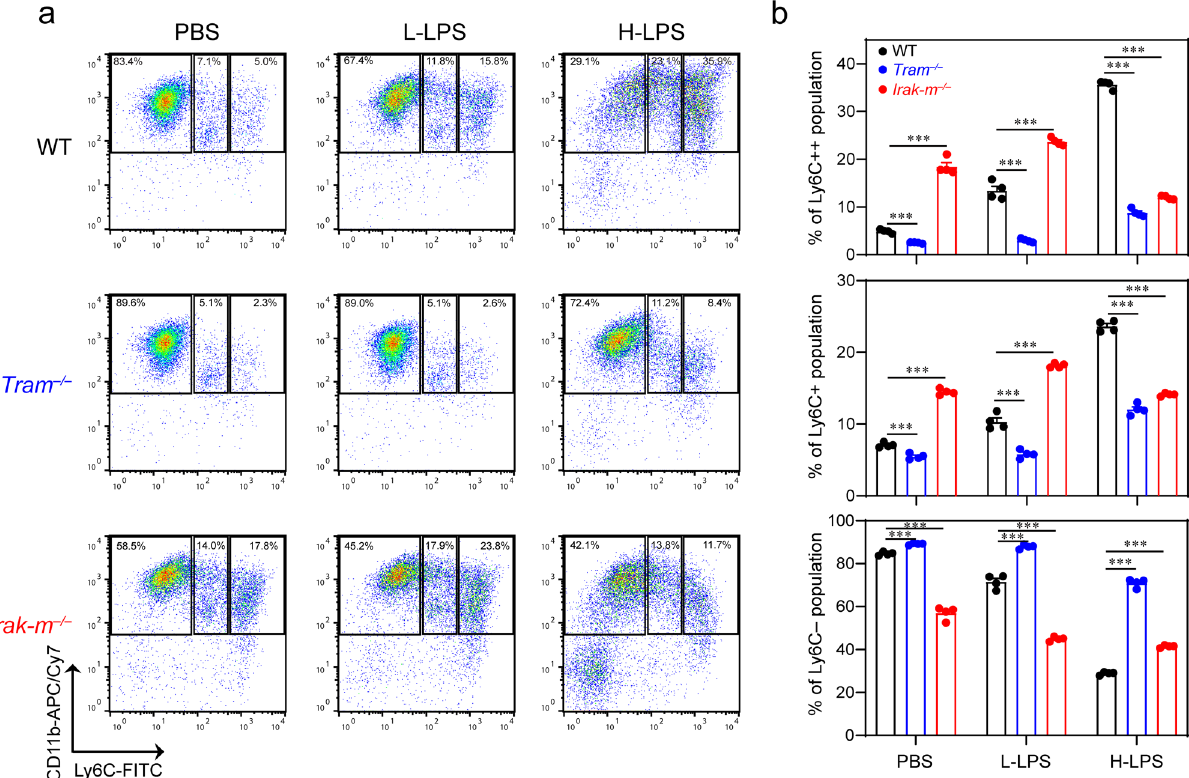
Fig. 1 The generation of in fl ammatory monocytes under persistent low-grade or exhaustive challenges, facilitated by TRAM and fi nely modulated by IRAK-M. Primary murine monocytes from WT, Tram − / − and Irak-m − / − mice were treated with either PBS, low-dose LPS (100 pg/mL) or high-dose LPS (1 µ g/mL) for 5 days, and monocyte subsets were analyzed with fl ow cytometry. a Representative staining pro fi le of the monocyte subsets. b Quanti fi cation of the populations of non-classical (Ly6C − ); intermediate (Ly6C + ); and classical monocytes (Ly6 + + ). Data are representative of three independent experiments, and error bars represent means ± SEM. *** P < 0.001; one-way ANOVA ( n = 4 for each